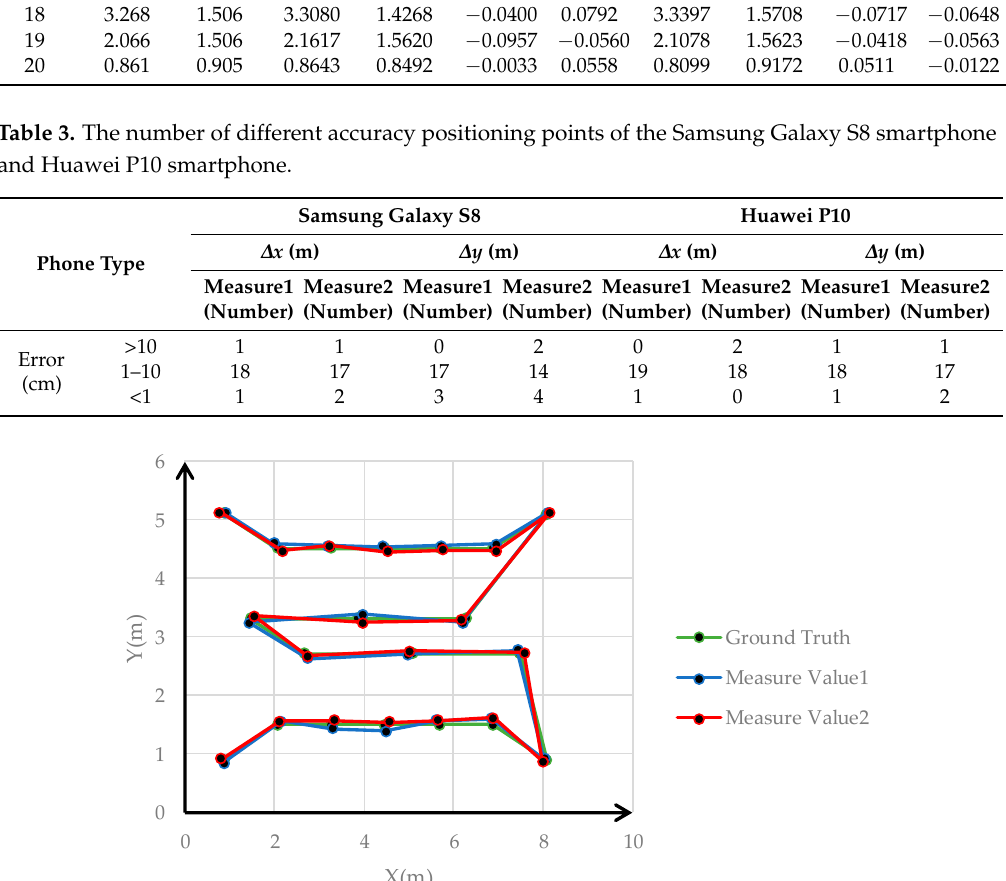
Figure 15. Comparison of measurements results of the Huawei P10 and corresponding ground truth.